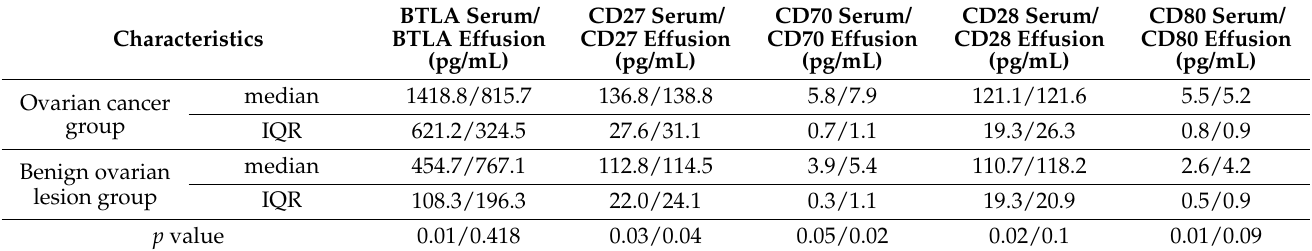
Table 3. Levels of serum and peritoneal fluid concentrations of the studied proteins in ovarian cancer group and benign ovarian lesion group.